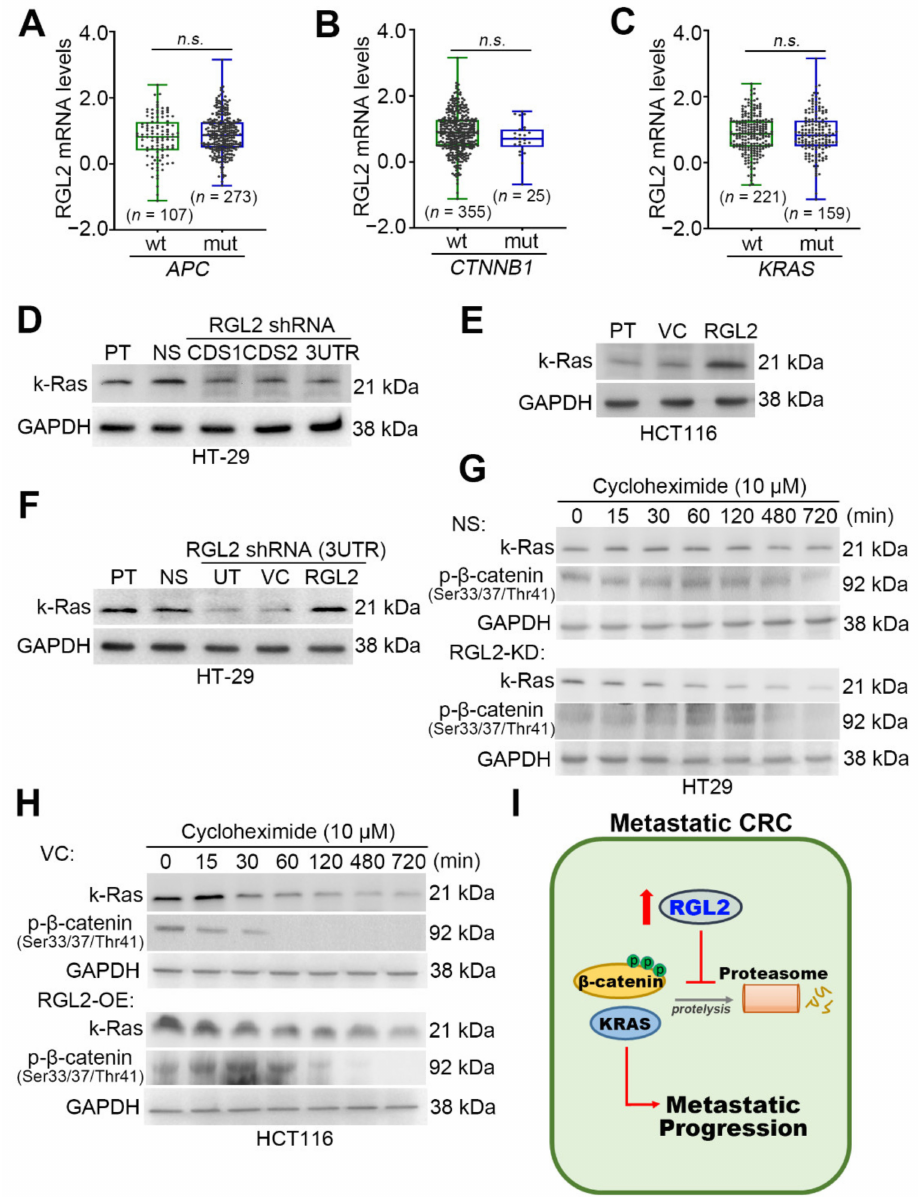
Figure 6. RGL2 expression is irrelevant to KRAS mutation but regulates the protein levels of KRAS in CRC. Boxplot for the transcriptional profiling of RGL2 in the TCGA samples without (wild-type, wt) or with (mutant, mut) APC ( A ), β -catenin ( CTNNB1 , ( B ) and KRAS ( C ) mutations. The “n.s.” denotes not significant. Western blot analyses for the protein levels of KRAS and GAPDH in the designated HT-29 ( D , F ) and HCT116 ( E ) cell variants. ( G , H ) Western blot analyses of the protein levels of KRAS, phosphorylated β -catenin at Ser33/37/Thr41 and GAPDH in cycloheximide (10 µ M)-treated NS/RGL2-KD HT-29 and VC/RGL2-OE HCT116 cell variants at the indicated time intervals. In (D), (E), (F), (G), and (H), GAPDH was used as an internal control for protein loading. ( I ) An illustration of the proposed model for RGL2-promoted metastatic progression in CRC. The full Western blot images of D, E, F, G and H are shown in Figure